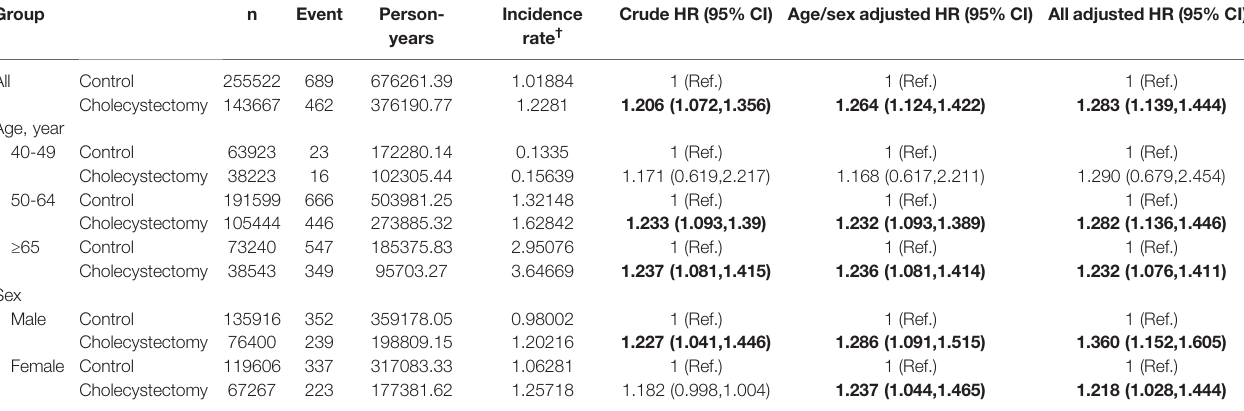
TABLE 5 | Incidence of hip fracture in cholecystectomy group and control group according to age and sex subgroups. Group n Event Person-